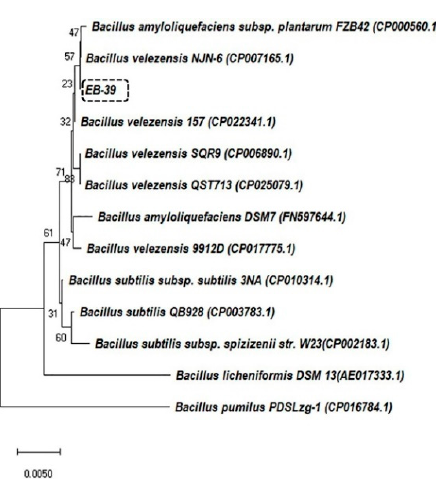
Figure 1. Phylogenetic tree based on the 16S rRNA gene sequences that highlights the position of EB-39 relative to the other strain types within the genus Bacillus . Accession numbers retrieved from the